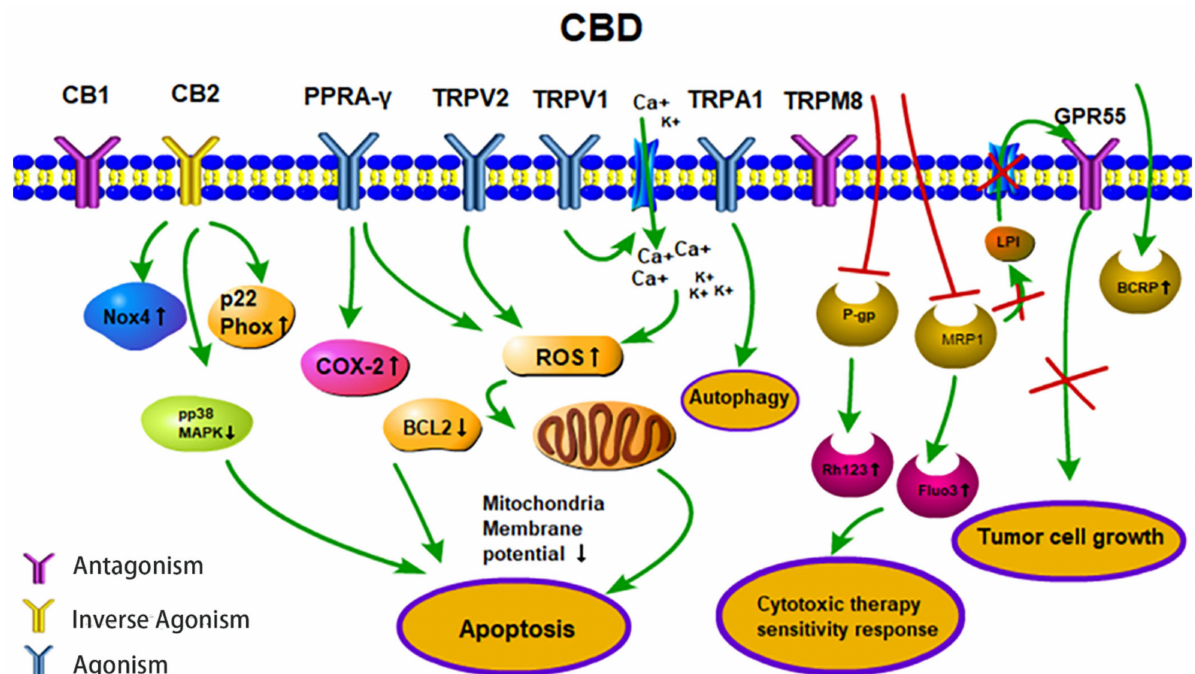
Figure 2. Anti-tumor activities (apoptosis, therapy sensitivity, autophagy, tumor cell growth) of CBD. CBD acts as an agonist for the receptors TRPV1/2, TRPA1 and PPAR γ . CBD acts as an inverse agonist of the receptors CB1/CB2 and as an antagonist of the receptors GPR55 and TRPM8. CBD inhibits the efflux transporters P-gp and MRP1 and thereby reverses multi-drug resistance. CBD inhibits the MRP1 pump LPI out and the autocrine loop with GPR55 thereby reduces cell proliferation. Abbreviations: BCRP, breast cancer resistance protein; BCL2, B-cell lymphoma 2; CB1/2, cannabinoid receptors type 1/2; CBD, cannabidiol; COX-2, cyclooxygenase 2; Fluo3, substrate of MRP1; GPR55, G-protein-coupled receptor 55; LPI, lysophospholipid lysophosphatidylinositol; MRP1, multidrug resistance-related protein 1; NOX4, NADPH oxidase 4; PPAR γ , peroxisome proliferator-activated receptor-gamma; P-gp, P-glycoprotein; p22 Phox, human neutrophil cytochrome b light chain; Rh123, P-gp substrate rhodamine 123; ROS, reactive oxygen species; TRPV1/2, transient receptor potential vanilloid type 1/2; TRPA1, TRP ankyrin type-1; TRPM8, TRP melastatin